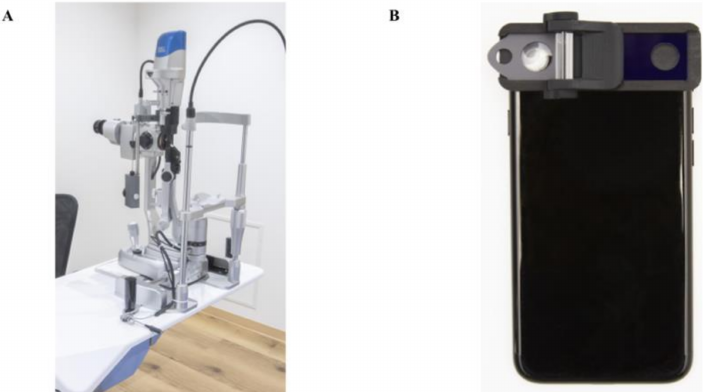
Figure 1. Photographs of the conventional slit-lamp microscope and the smart eye camera (SEC). ( A ) Appearance of the conventional slit-lamp microscope (700GL; Takagi, Nagano, Japan). External camera is installed inside (THD-23FHD; IKEGAMI TSUSHINKI CO., LTD., Tokyo, Japan). ( B ) Ap- pearance of the smart eye camera (OUI Inc., Tokyo Japan). The attachment includes a thin slit and a cylinder lens to converts the light source from the smartphone into a 1-mm thin beam.